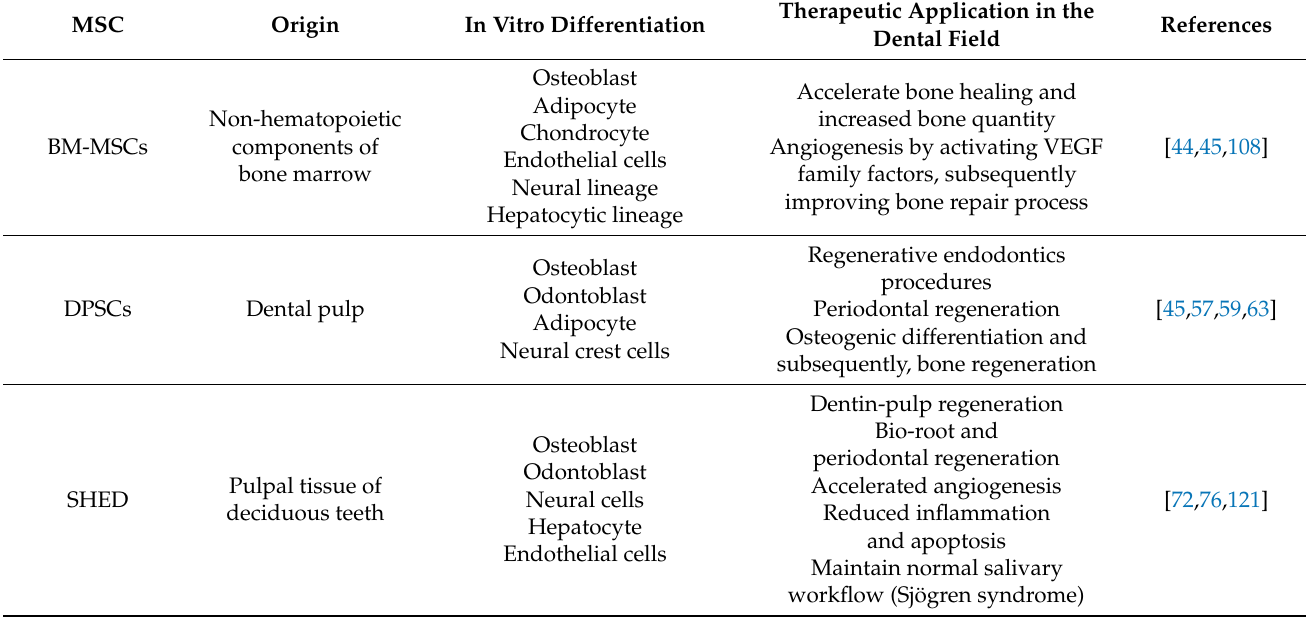
Table 2. Types of stem cells used in regenerative dentistry, their origin, in vitro differentiation potential and therapeutic applications in regenerative